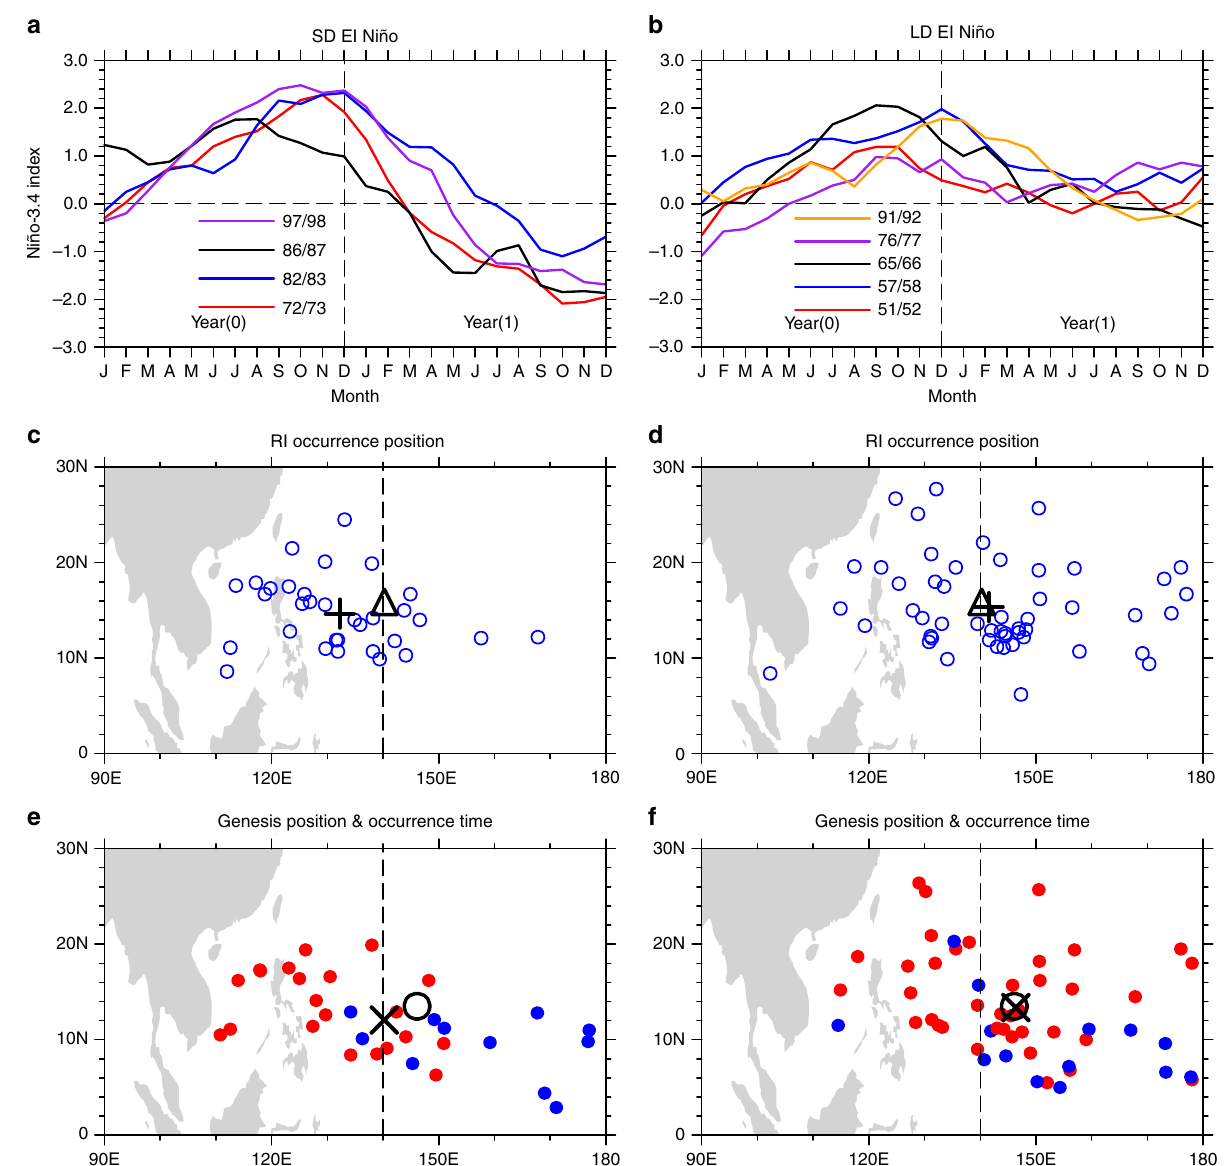
Fig. 1 El Niño durations and their impacts on the tropical cyclone rapid intensi fi cation. The time series of monthly mean Niño-3.4 indices based on ERSST reanalysis dataset from January of the El Niño developing year to December of the decaying year for a short duration (SD) El Niño events and b long duration (LD) El Niño events. El Niño developing and decaying years are denoted by year(0) and year(1), respectively. The composite tropical cyclone (TC) rapid intensi fi cation (RI) occurrence positions from JTWC best-track dataset for c SD and d LD El Niño events are shown as blue circles. The triangles in c , d indicate the mean RI occurrence position for neutral years. The crosses in c , d indicate the mean RI occurrence positions for SD and LD El Niño events, respectively. The composite RI TC genesis positions for e SD and f LD El Niño events are shown as colored dots. The red (blue) dots indicate the RI occurrence time is within (beyond) 3 days of TC genesis. The circles in e , f indicate the mean RI TC genesis position for neutral years. The x-marks in e , f indicate the mean RI TC genesis position for SD and LD El Niño events, respectively. The dashed lines in c – f indicate the 140°E